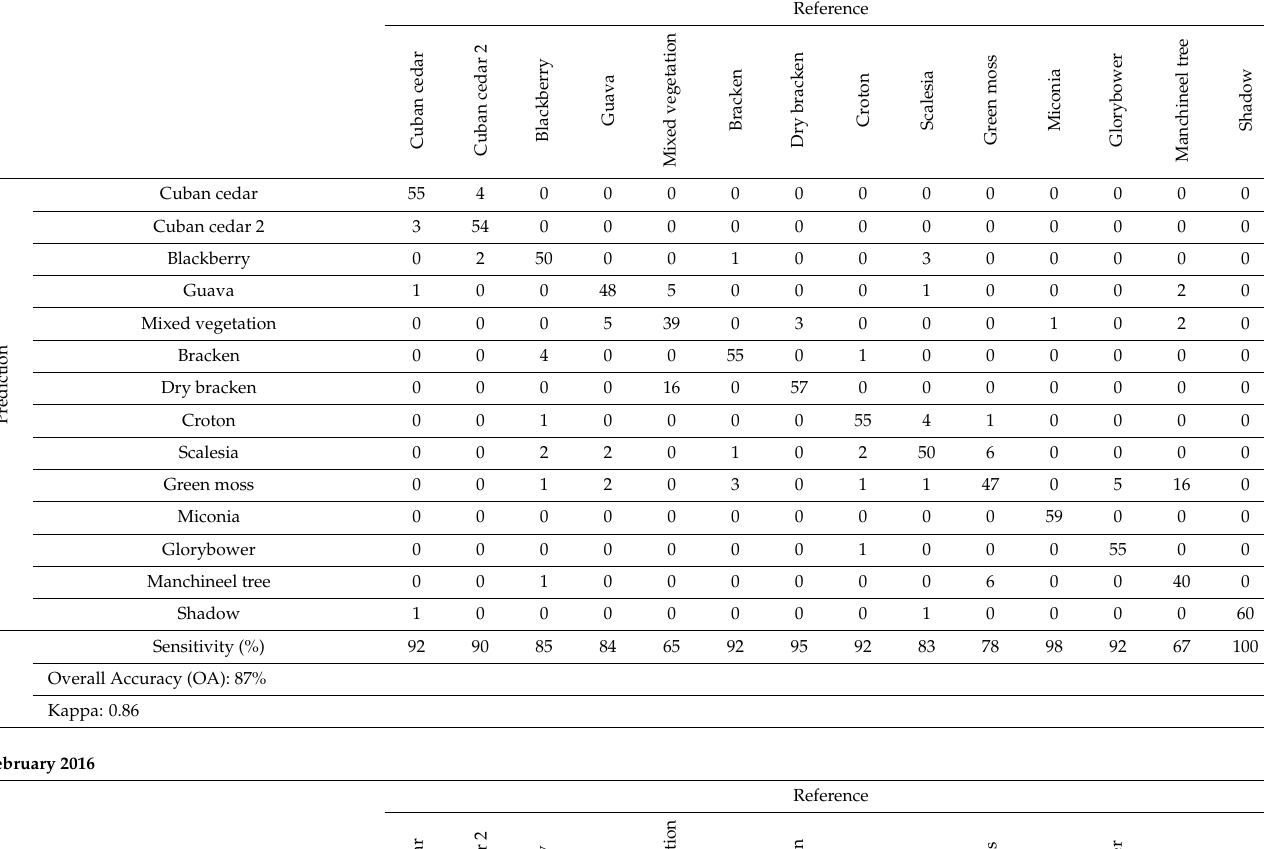
Table A1. Complete confusion matrices calculated with the validation points from the Random Forest (RF) models of each WorldView-2 (WV-2)